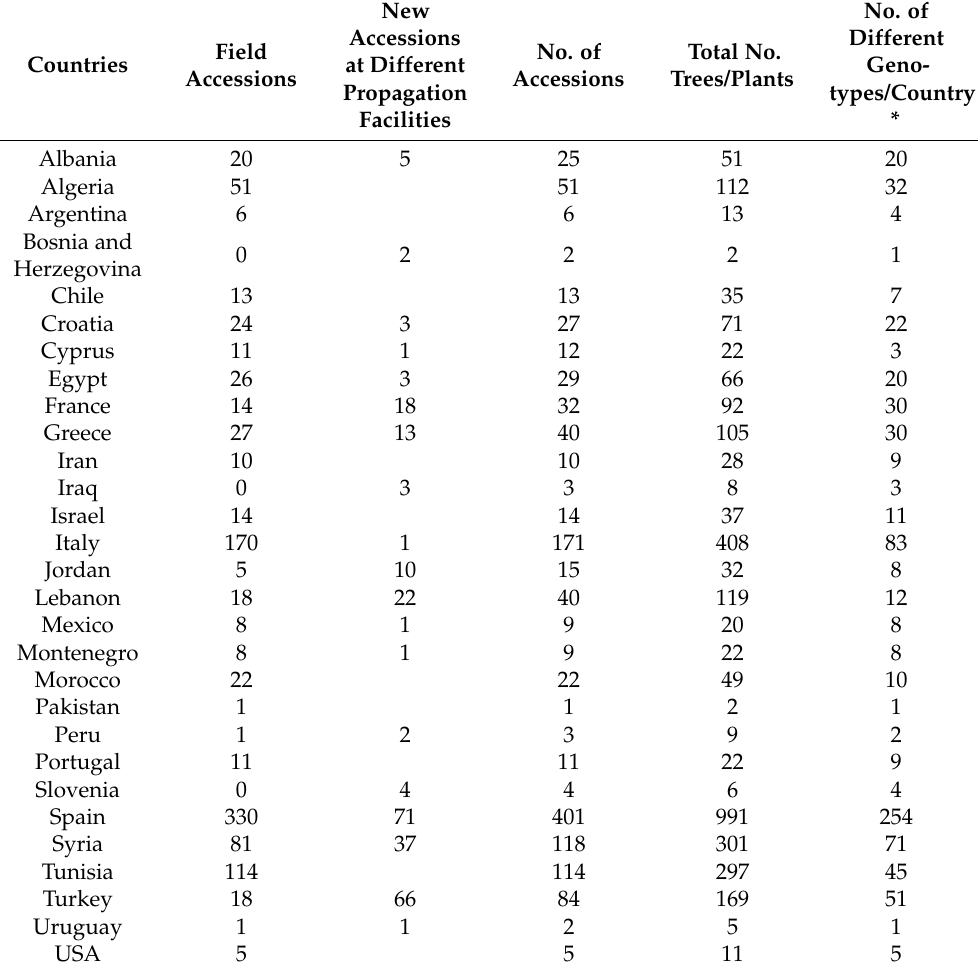
Table 1. Number of accessions (field and new acquired ones) genotyped per country and number of different cultivars identified in each country.